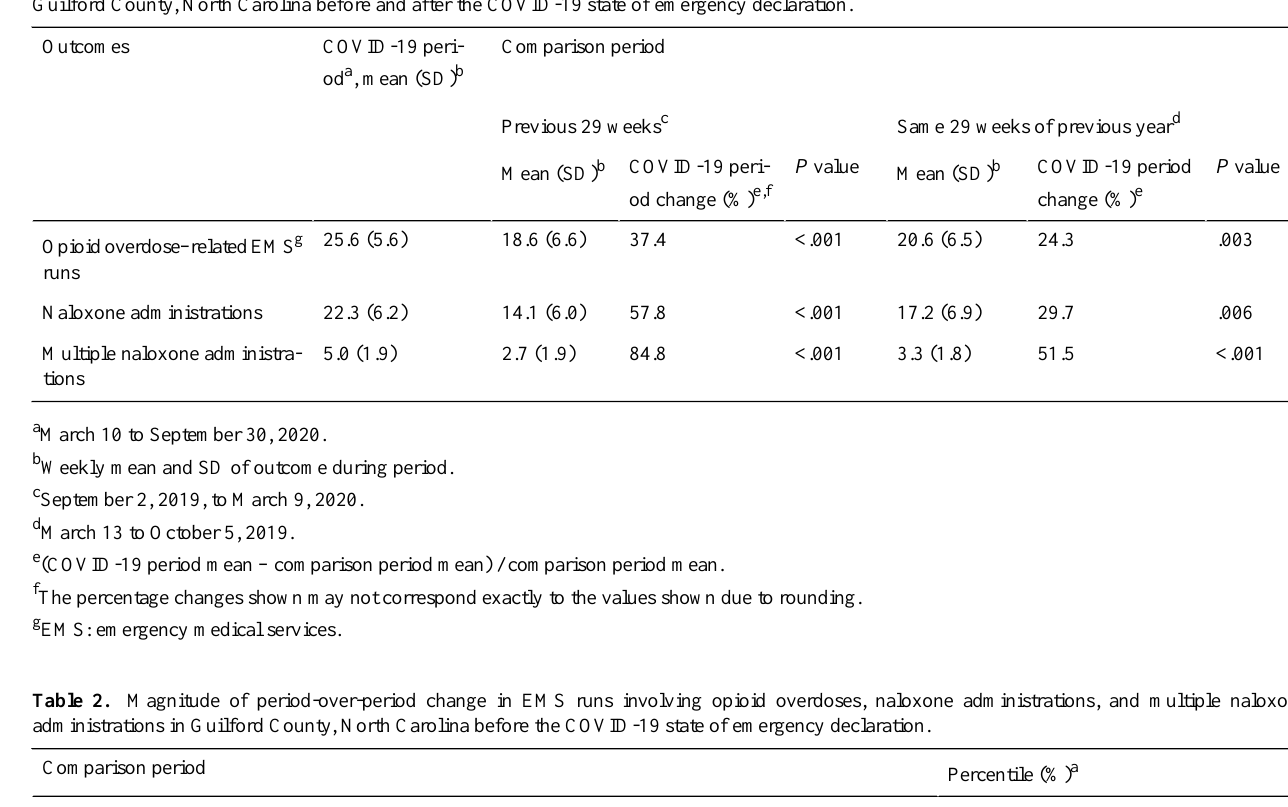
Opioid overdose–related EMS b